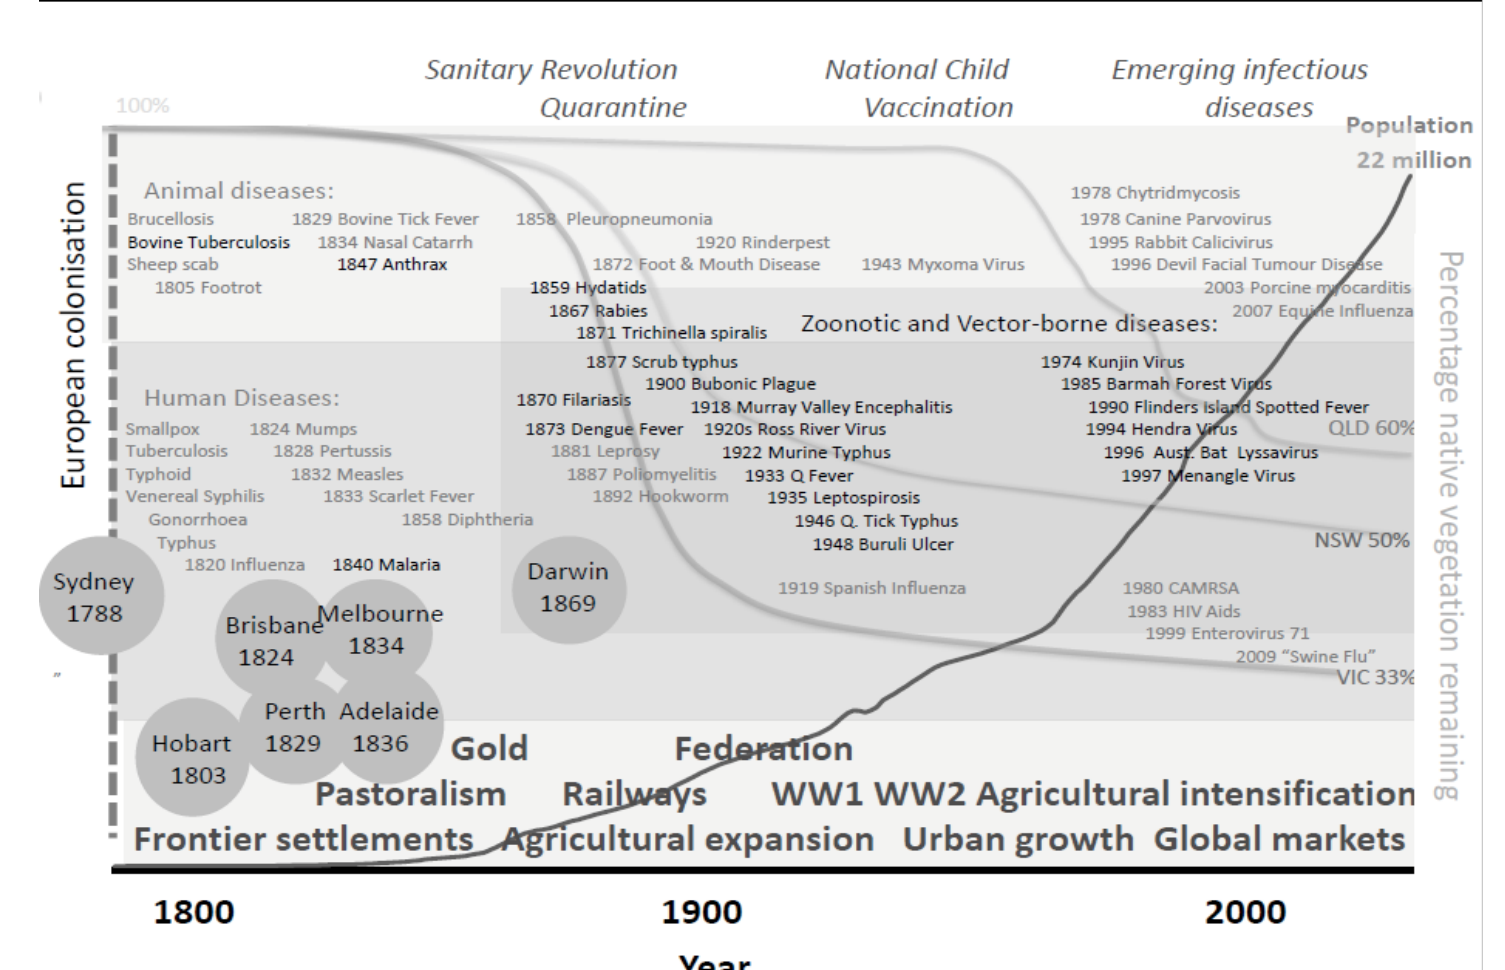
Figure 3. The history of infectious diseases emergence in Australia 1788–2009 with key development and public health events. Data compiled from historical literature and systematically reviewed literature (see Online Supplementary Information, Appendix 1 and Table 1 for full